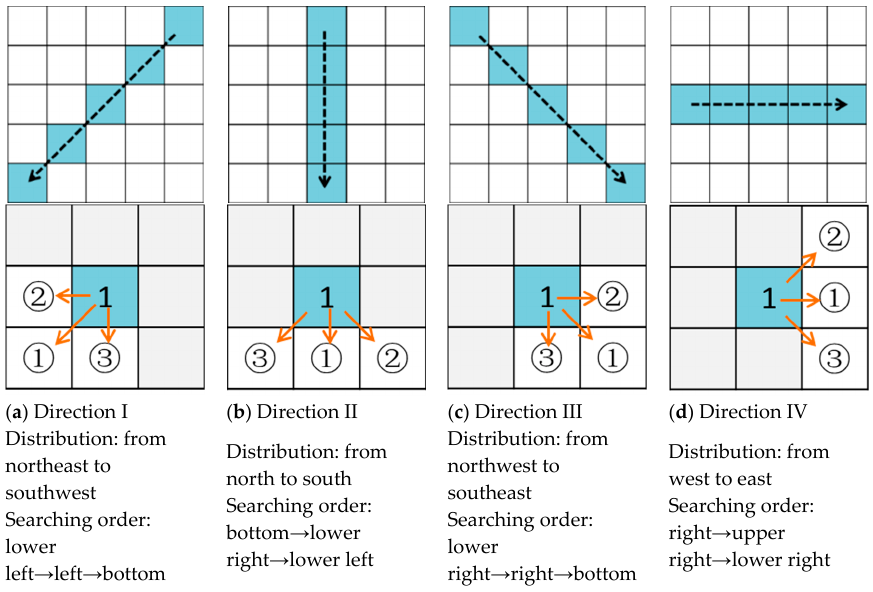
Figure 6. Ephemeral gully directions and their searching order.